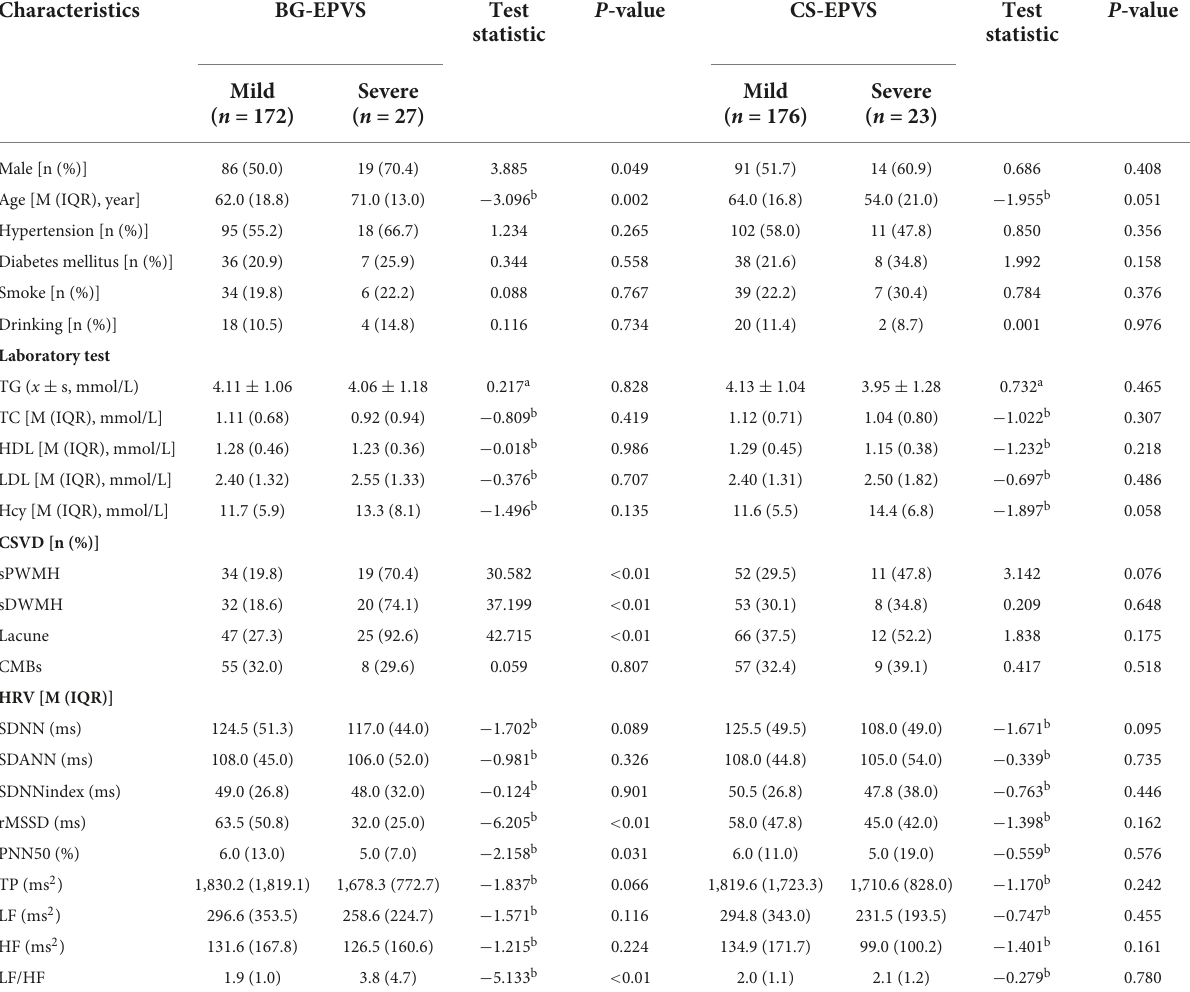
TABLE 1 Univariate analysis of factors related to enlarged perivascular space (EPVS) load in different brain regions. Characteristics BG-EPVS Test